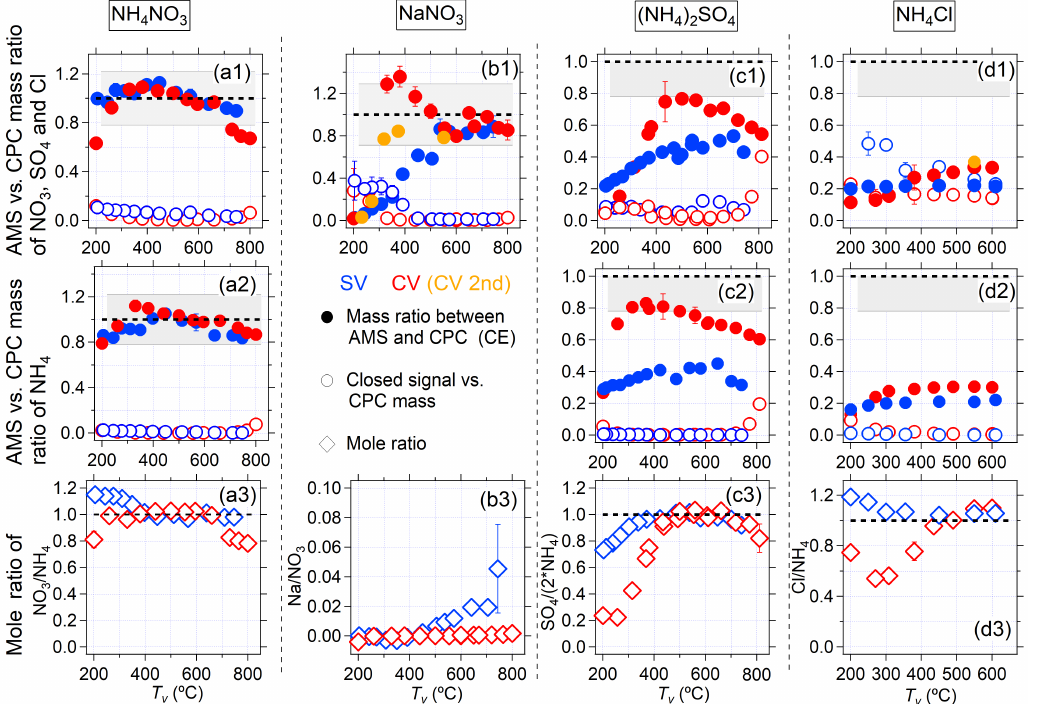
Figure 9. Ratio of mass concentration between AMS and CPC measurements (CE) from four inorganic species (dried monodisperse particles) of (a) 300nm NH 4 NO 3 , (b) 250nm (NH 4 ) 2 SO 4 , (c) 300nm NaNO 3 , (d) 300nm NH 4 Cl, as a function of T v in the SV and CV. Apparent mole ratios between the anion and cation (a3, c3 and d3) and cation and anion (b3) are also shown (bottom row). The NaNO 3 AMS / CPC mass ratios were corrected based on the measured lens transmission curve in Fig. S2 (see text) to account for the lens transmission loss. The orange traces in (c1) and (d1) are results from repeat CV experiments. The mole ratio of (NH 4 ) 2 SO 4 is SO 4 vs. 2NH 4 . RIE of sodium was assumed to be 1 here since no explicit RIE of Na has been reported to our knowledge, and since this species is both slow to vapourize and prone to surface ionization in the AMS. The grey area is the Monte Carlo propagated error for measured AMS / CPC mass ratios, assuming 10% error for CPC counting, 15% error for DMA size-selection, 5% for shape factor, 10% for RIE, and 15% error for lens transmission. Lens transmission error is only applied in the error calculation of NaNO 3 calculation. Finally, a total uncertainty of 29% is estimated for NaNO 3 and 22% for the